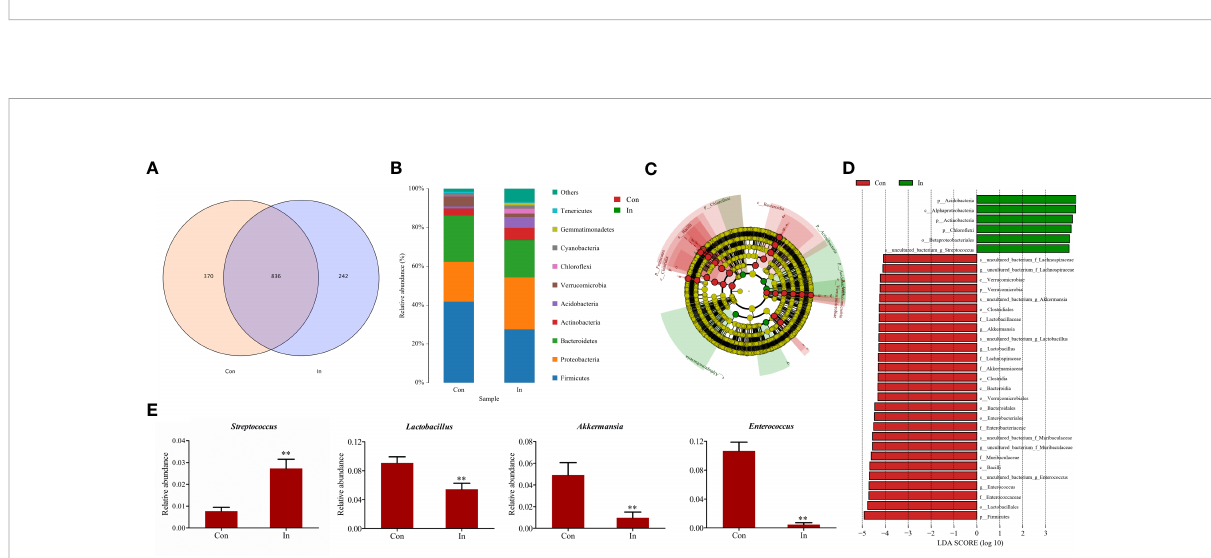
FIGURE 6 Difference analysis of intestinal microbiota of largemouth bass following MSRV infection. (A) The Venn diagram for showing OUT numbers. (B) The bar plots for Microbial community. (C) Lefse analysis of differential fl ora. LDA threshold is 4.0; red node indicates enrichment in the control group; green node indicates enrichment in the infection group. (D) The LDA scores of different microbes between control group and infection group. Red means the control group; green means the infection group. (E) Comparison of the relative abundance of partial different microbes between control group and infection group. Two asterisk represented statistical signi fi cance between infection group and control group. ( p <